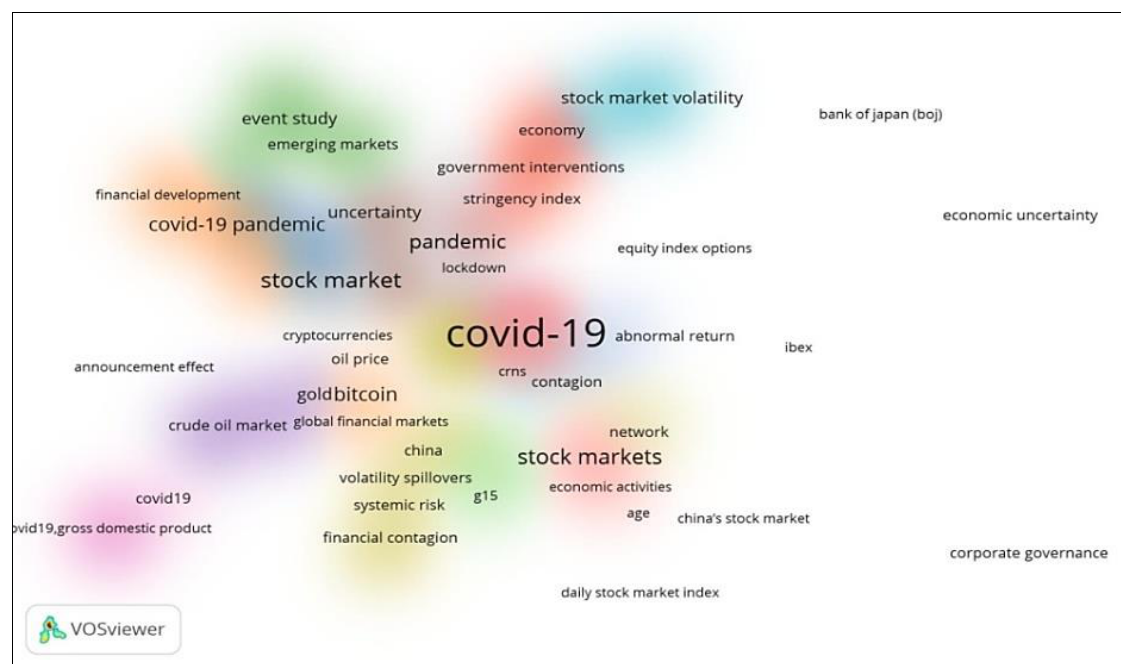
Figure 15. Cluster Density Visualization